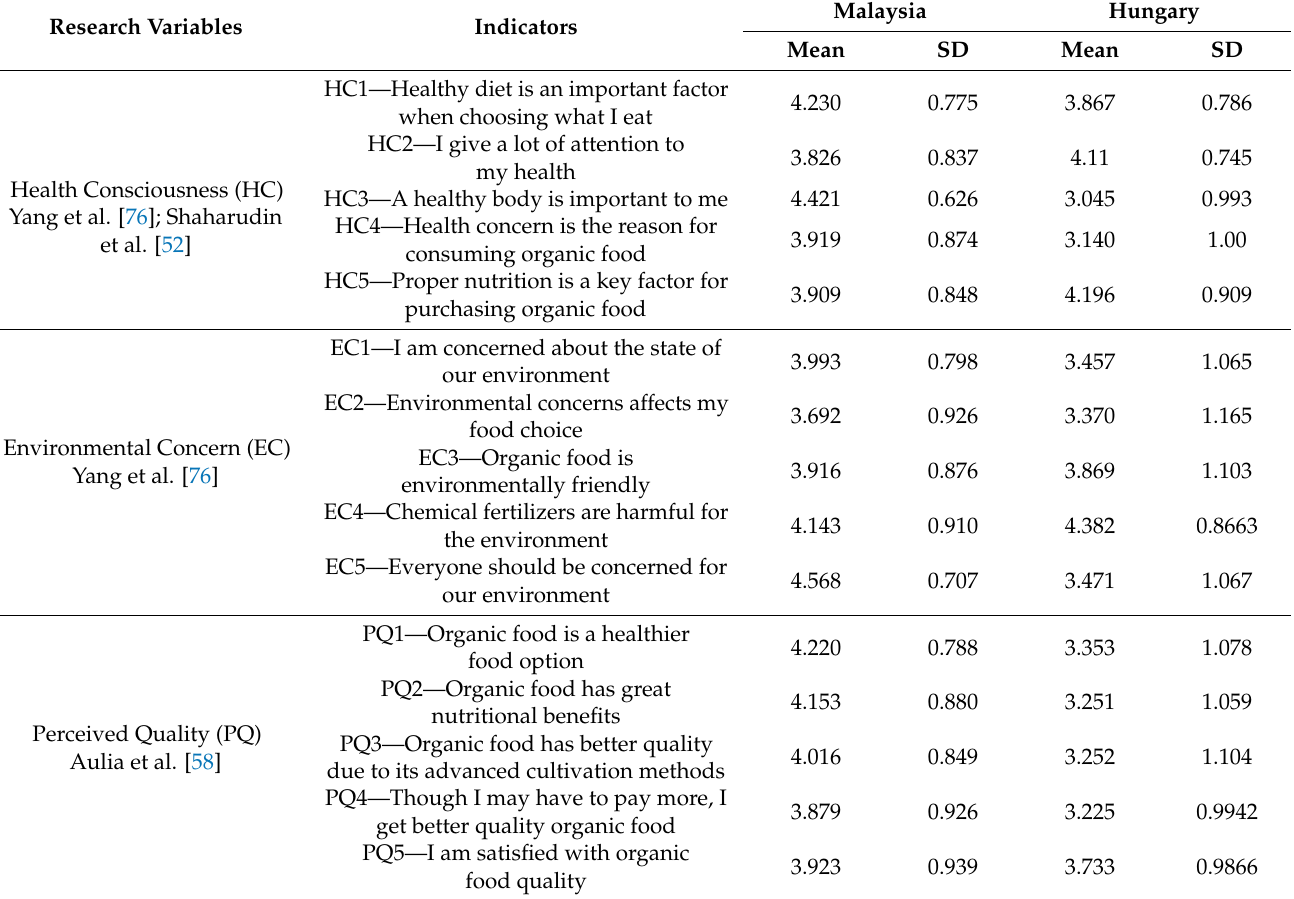
Table 2. Research variables and indicators with mean and standard